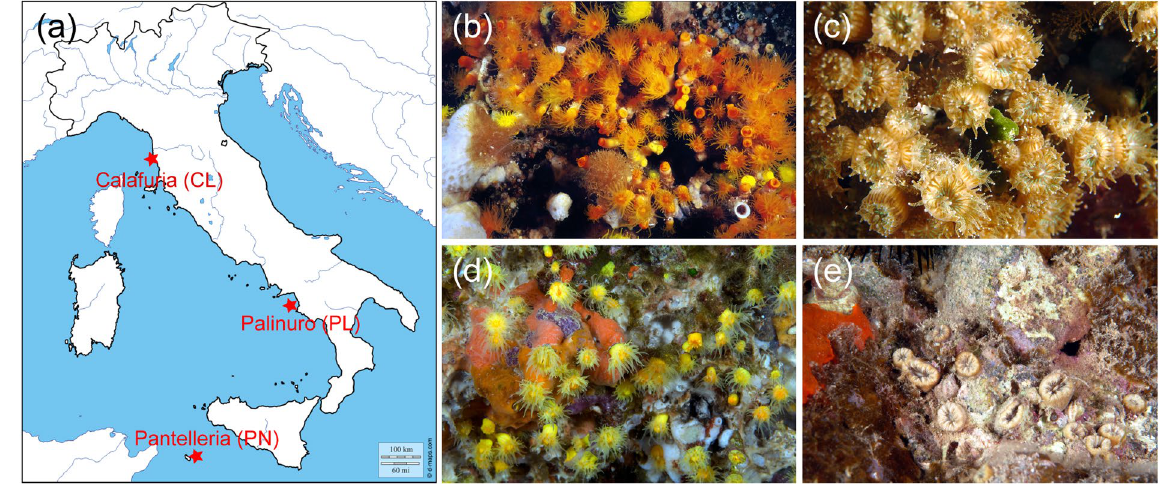
Figure 1. Collection sites and species. ( a ) Map of Italy showing the sites where corals were collected: Pantelleria island (PN), Palinuro (PL) and Calafuria (CL). ( b – e ) In situ camera pictures of the studied species: ( b ) A . calycularis , ( c ) C . caespitosa , ( d ) L . pruvoti and ( e ) B . europaea . The map of Italy was downloaded from the web site http://d-maps.com/carte.php?num_car = 2332&lang = en (no permission required) and labeled